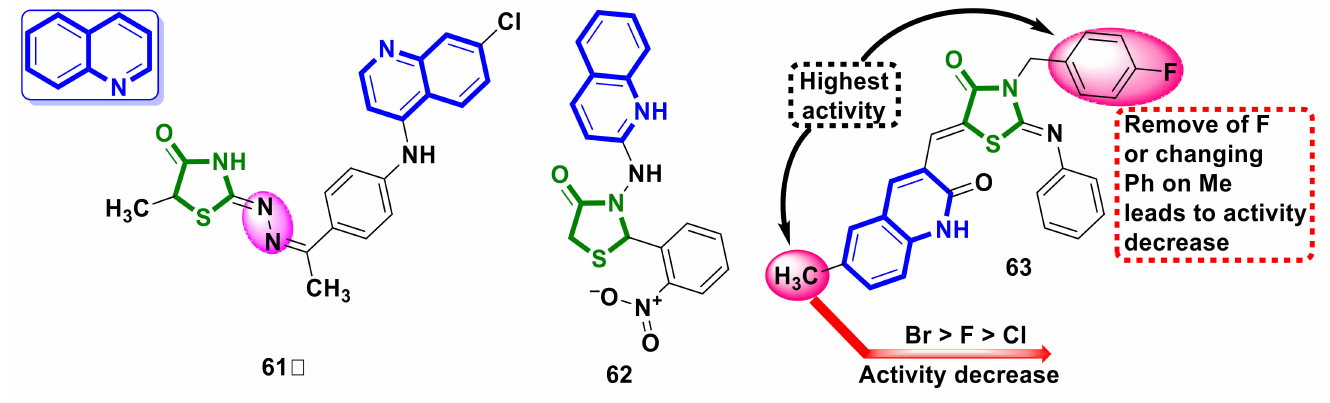
Figure 24. Quinoline-bearing hybrid molecules with 4-thiazolidinone scaffolds as potential anticancer agents and selected SAR